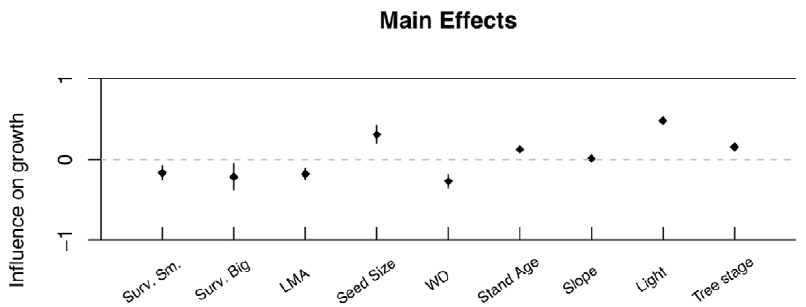
Figure 5. Main effects of the combined model. Because the variables were standardized using two standard deviations, the main effects of the combined model (Table 2) show standard deviation changes in growth given standard deviation changes in predictor variables, given that all other variables are held at the mean values across all species and conditions. Bars show standard errors of parameter coefficients. Light shows the largest positive influence, but other variables, through their interactions, also affect growth (Table